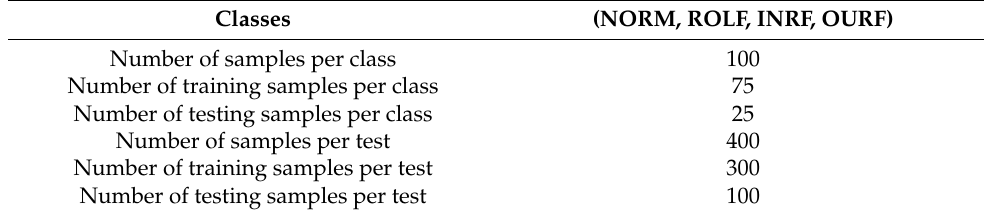
Table 2. Details of the dataset for training and testing based on the SVM.